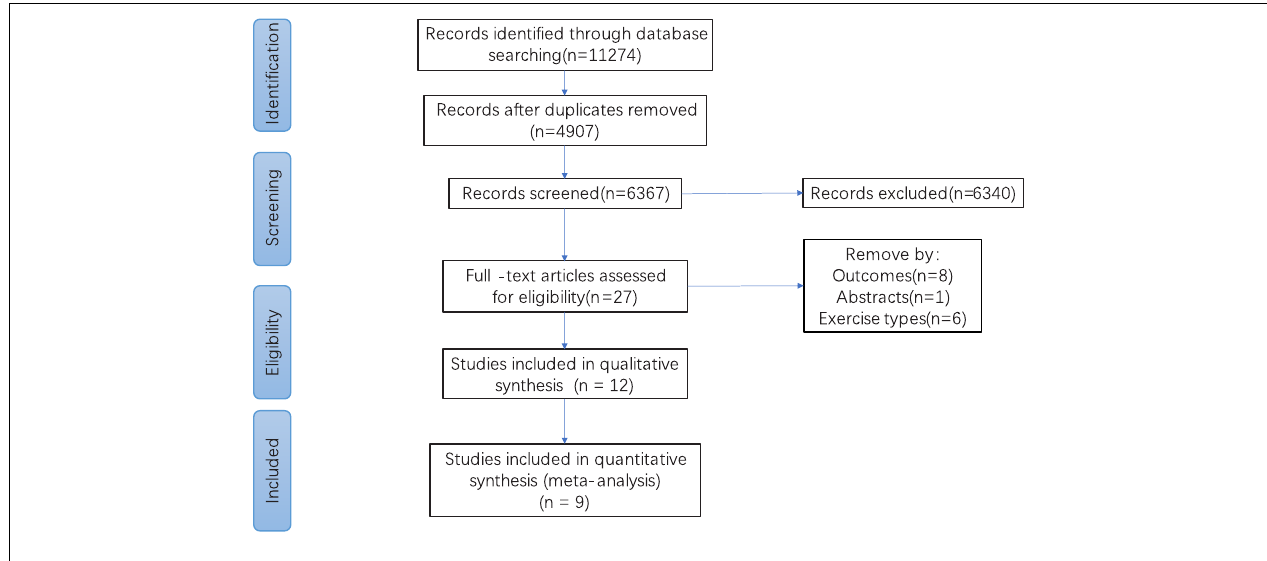
FIGURE 1 | Study flow